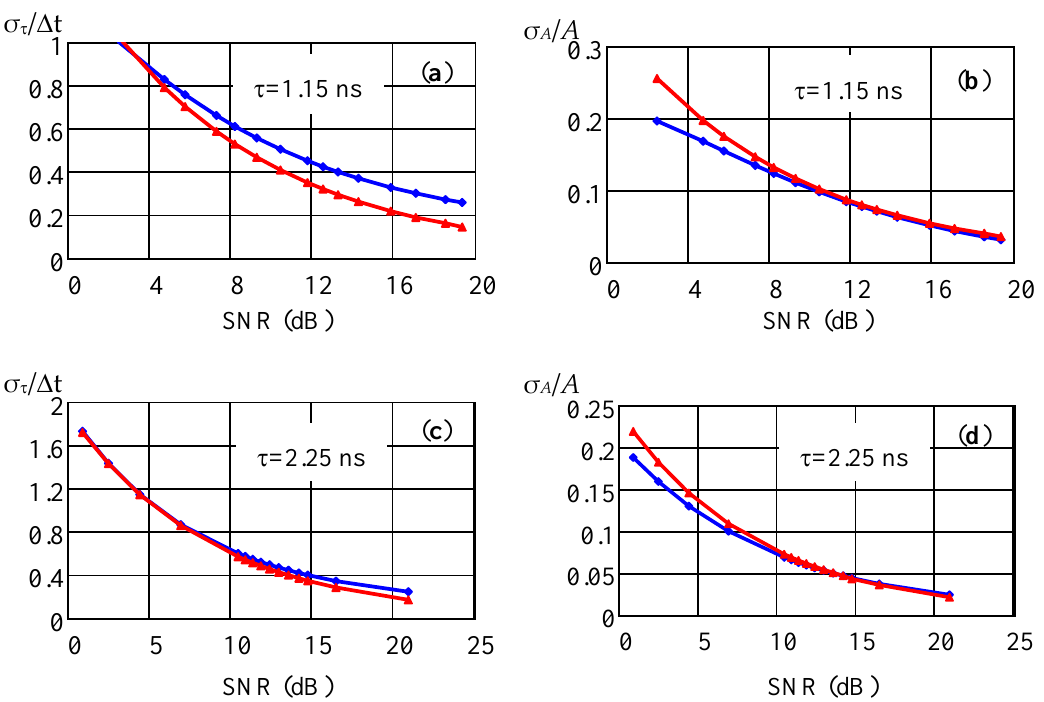
Figure 6. Dependences of the normalized standard deviations of the delay time estimate ( a , c ) and the signal amplitude estimate ( b , d ) on the SNR value for different values of the parameter τ = 1.15 ns and τ = 2.25 ns, f s = 6 GHz.